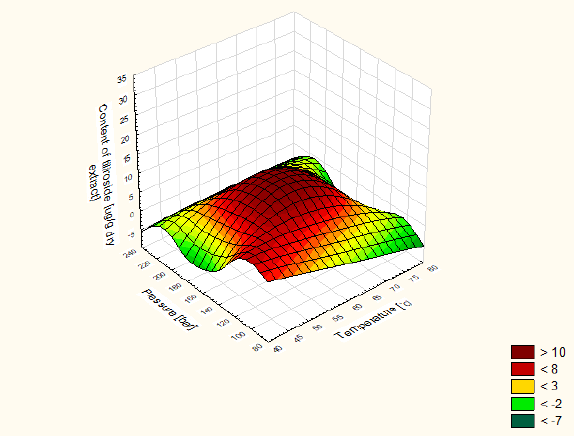
Figure 1: Surface chart 3W of the content of tiliroside vs. temperature and pressure of extraction (for 5% ethanol concentration) (Smoothing of smallest squares weighted by